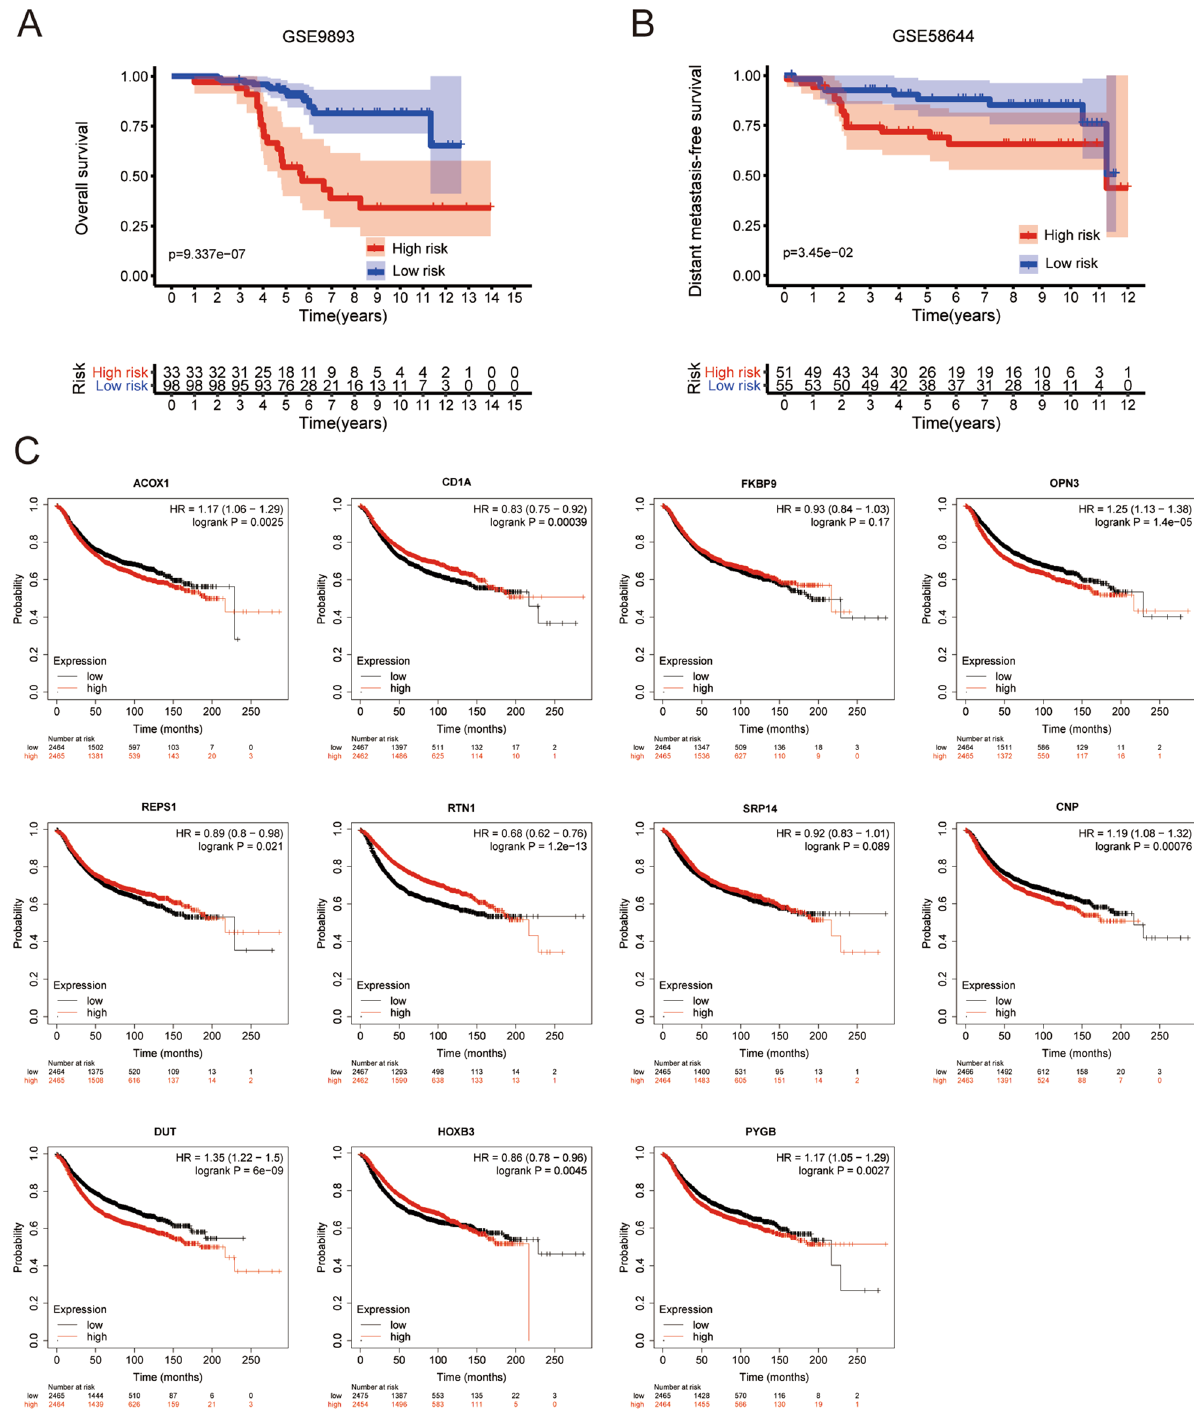
Figure 5. Prognostic value of the risk prediction model. ( A ) Kaplan–Meier OS curve in GSE9893; ( B ) DMFS curves for breast cancer patients in GSE58644; ( C ) Kaplan–Meier survival curves according to genes in the